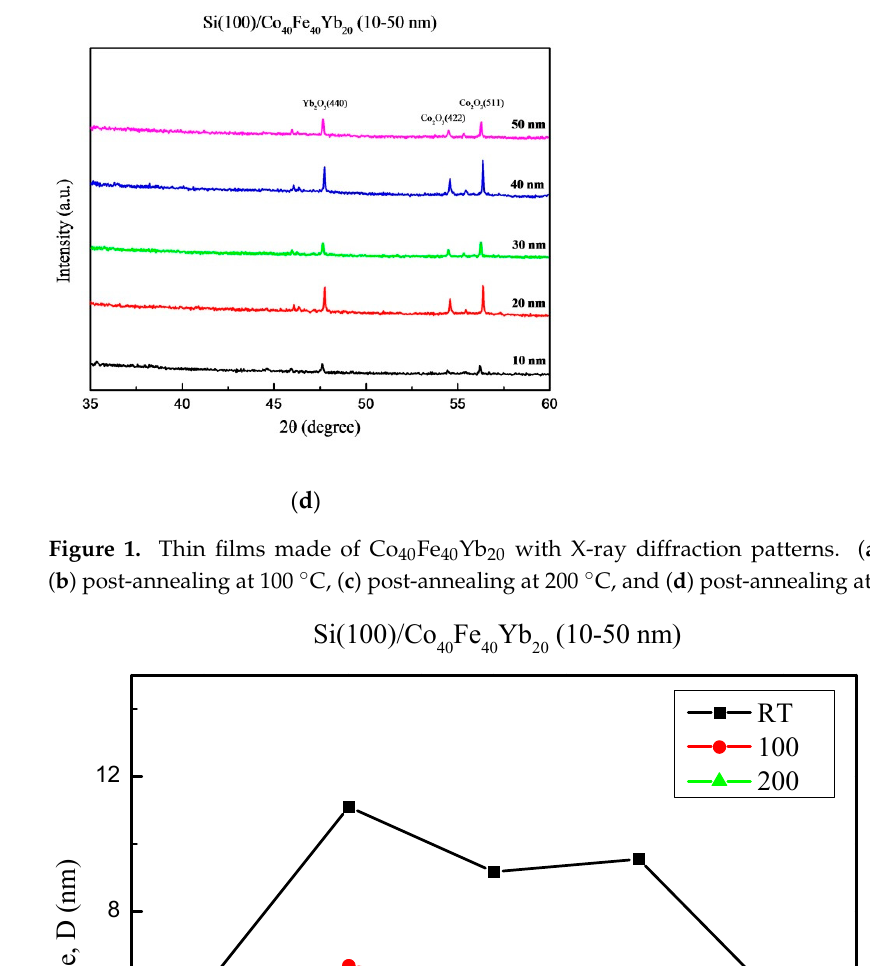
Figure 2. Grain size of Co 40 Fe 40 Yb 20 thin films with CoFe (110) diffracted peak. To demonstrate that the more oxidation effect of thinner thickness and lower an- nealed temperature is stronger than thicker thickness and higher annealed temperature, the FWHM of oxide diffracted peaks is shown in Figure 3a–e. From this result, it indi- cates that the FWHM of thinner thickness and lower annealed temperature is weaker than thicker thickness and higher annealed temperature, suggesting that the oxidation effect is more apparent in thinner thickness and lower annealed temperatures. The magnetic, electrical, surface energy, and hardness of Co 40 Fe 40 Yb 20 films are significantly influenced by their degree of oxidation.